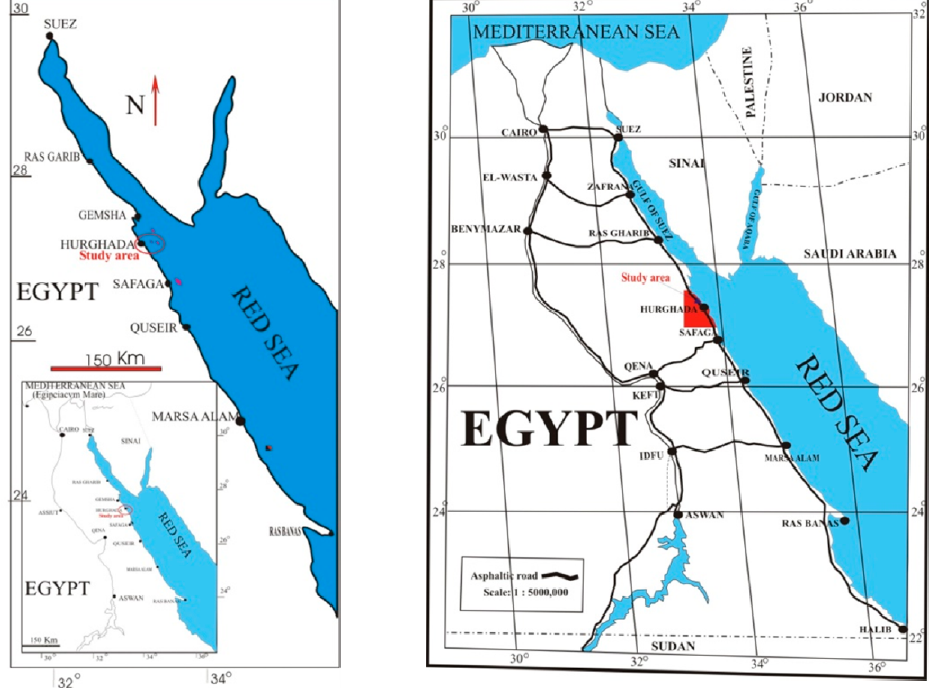
Figure 1. Location map of the study area along the Egyptian Red Sea coast.